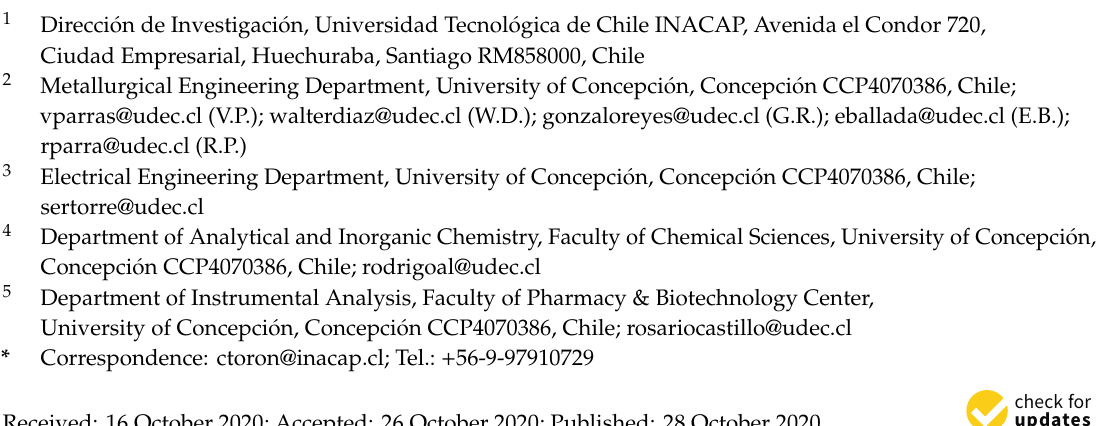
Figure 9. Non-linear curve fitting results for a spectrum from combustion of PyE sample,